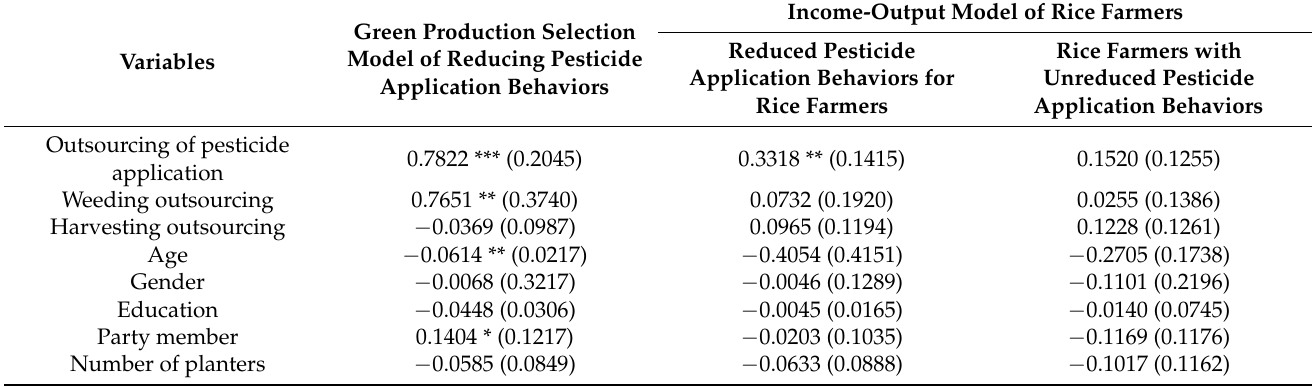
Table 5. Simultaneous estimation results of AGP selection model and rice income-output model for reducing pesticide application